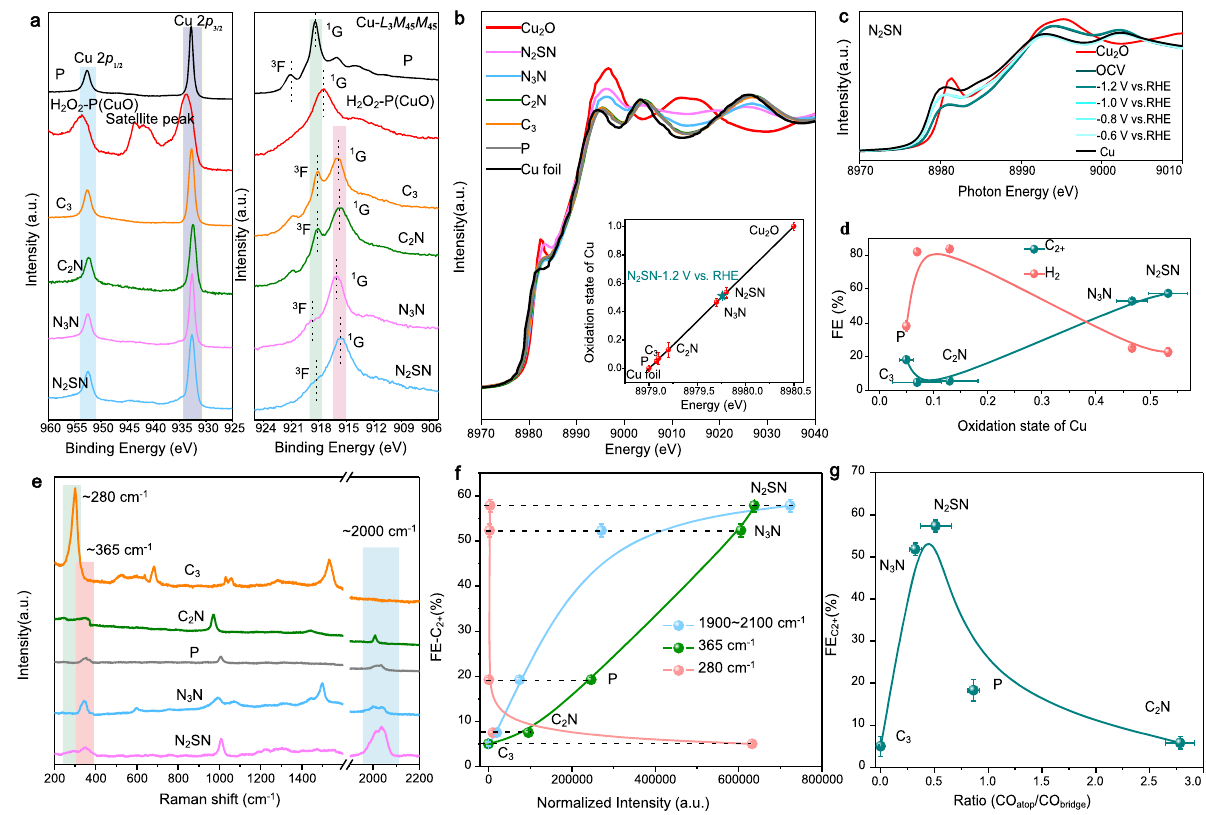
Fig. 3 Physical characterizations of the functionalized electrodes using XPS and operando Raman and XAS spectroscopy. a High-resolution spectra of the Cu 2 p regions and Cu L 3 M 45 M 45 Auger transition modes measured by ex situ X-ray photoelectron spectroscopy (XPS) of pristine Ag – Cu sample (P), H 2 O 2 -treated Ag – Cu (H 2 O 2 -P), C 3 -, C 2 N-, N 3 N- and N 2 SN- functionalized Ag – Cu electrodes. The different colored shading areas represent the peaks of Cu 2 p 1/2 (blue), Cu 2 p 3/2 (light purple), 1 G (pink) and 3 F (light green), respectively. b Ex situ and operando Copper K-edge X-ray absorption near-edge structure (XANES) spectra of pristine and functionalized Ag – Cu electrodes. Inset: Average oxidation state of copper for the corresponding electrodes. c Operando Cu K-edge XANES spectra of N 2 SN- functionalized Ag – Cu electrode during CO 2 RR. The measurements were performed after holding the applied potential for 30 min. d Evolution of the Faradaic ef fi ciency for C 2 + and H 2 measured at − 1.2 V vs. RHE with the oxidation state of Cu. e Operando Raman spectra for pristine, C 3 -, C 2 N-, N 3 N- and N 2 SN-, functionalized Ag – Cu during CO 2 RR at a fi xed potential of − 1.2 V vs. RHE. The different colored shading areas represent the peaks of 280 cm − 1 (light green), ~365 cm − 1 (pink), and ~2000 cm − 1 (blue), respectively. The spectra for all the other potentials are presented in Supplementary Fig. 26. f Relationship between the FE for C 2 + products and the Raman peak areas of the frustrated rotational mode of CO at 280 cm − 1 , the Cu – CO stretch at 365 cm − 1, and the C ≡ O stretch at 1900 – 2120 cm − 1 , respectively. g Relationship between the FE for C 2 + molecules and the ratio of CO atop and CO bridge on different Ag – Cu electrodes. The ratio was obtained from the integrated areas of the deconvoluted peaks of the Raman spectra (Supplementary Fig. 27). The error bars in b , d , f , and g correspond to the standard deviation of three independent